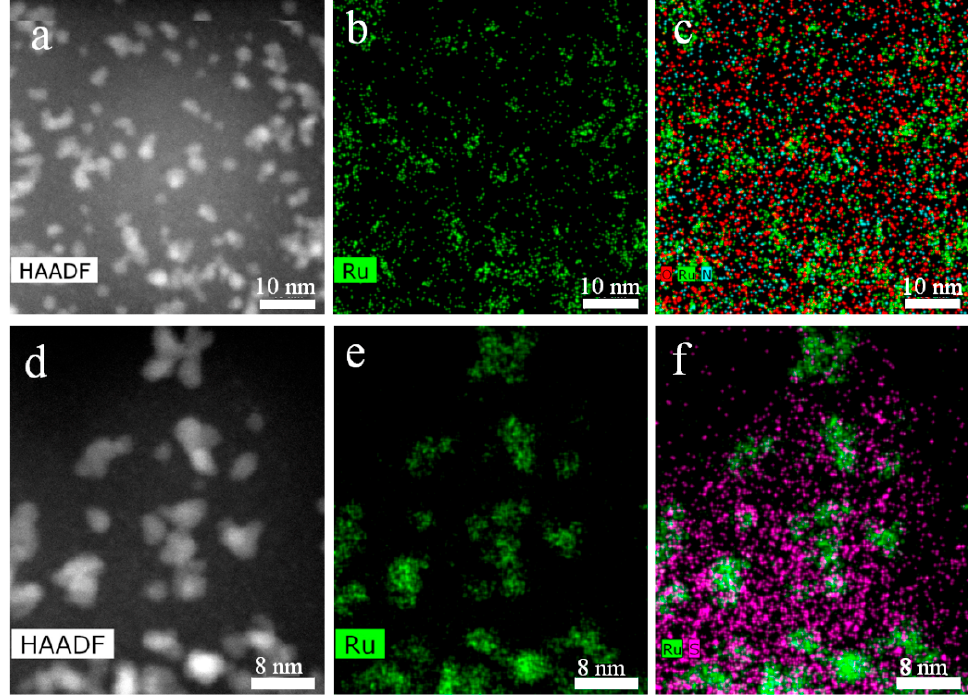
Figure 4. STEM dark-field image ( a ) and EDS maps for Ru ( b ), and Ru-O-N superpositions ( c ) for Ru-PPP and STEM dark-field image ( d ) and EDS maps for Ru ( e ), and Ru-S superpositions ( f ) for Ru-PPP-S.